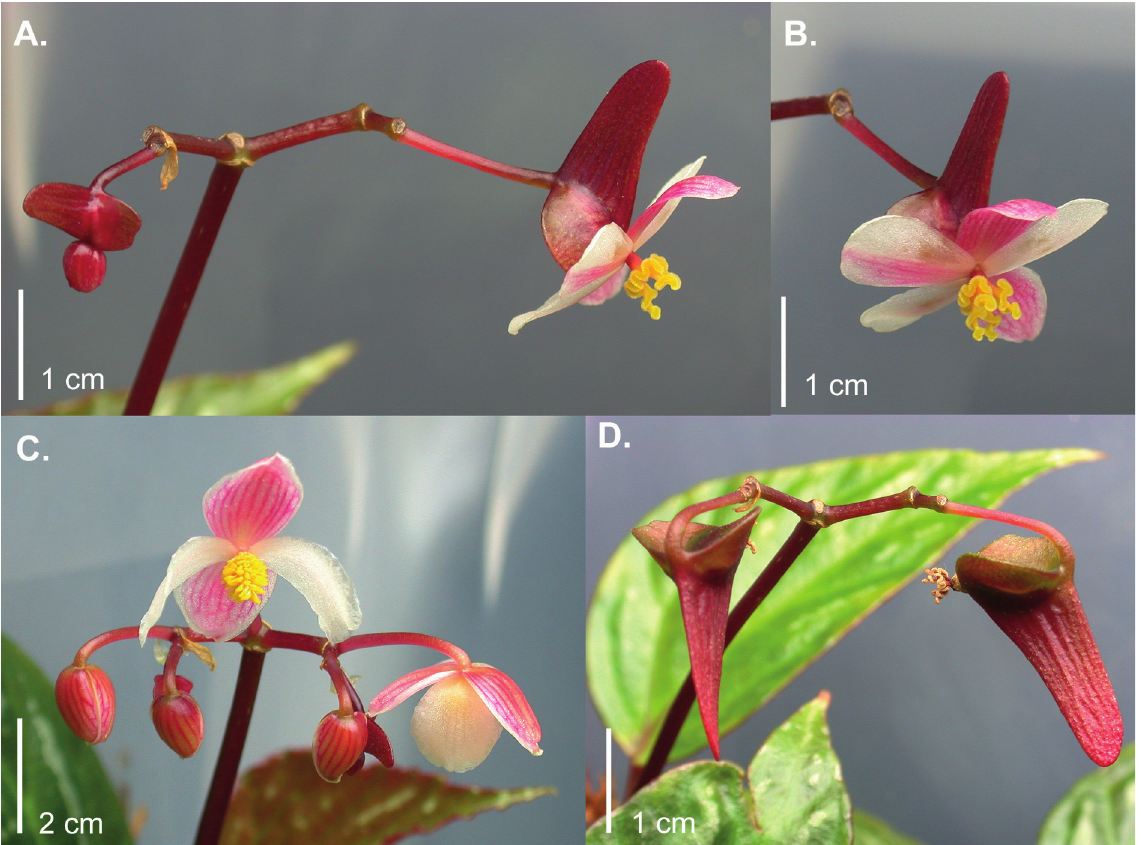
Fig. 29. Begonia hatacoa Buch.-Ham. ex D.Don. A . Female bud and side view of flower. B . Female flower front view. C . Male flower. D . Fruit. Photographs courtesy of John Boggan of a plant in cultivation in a private